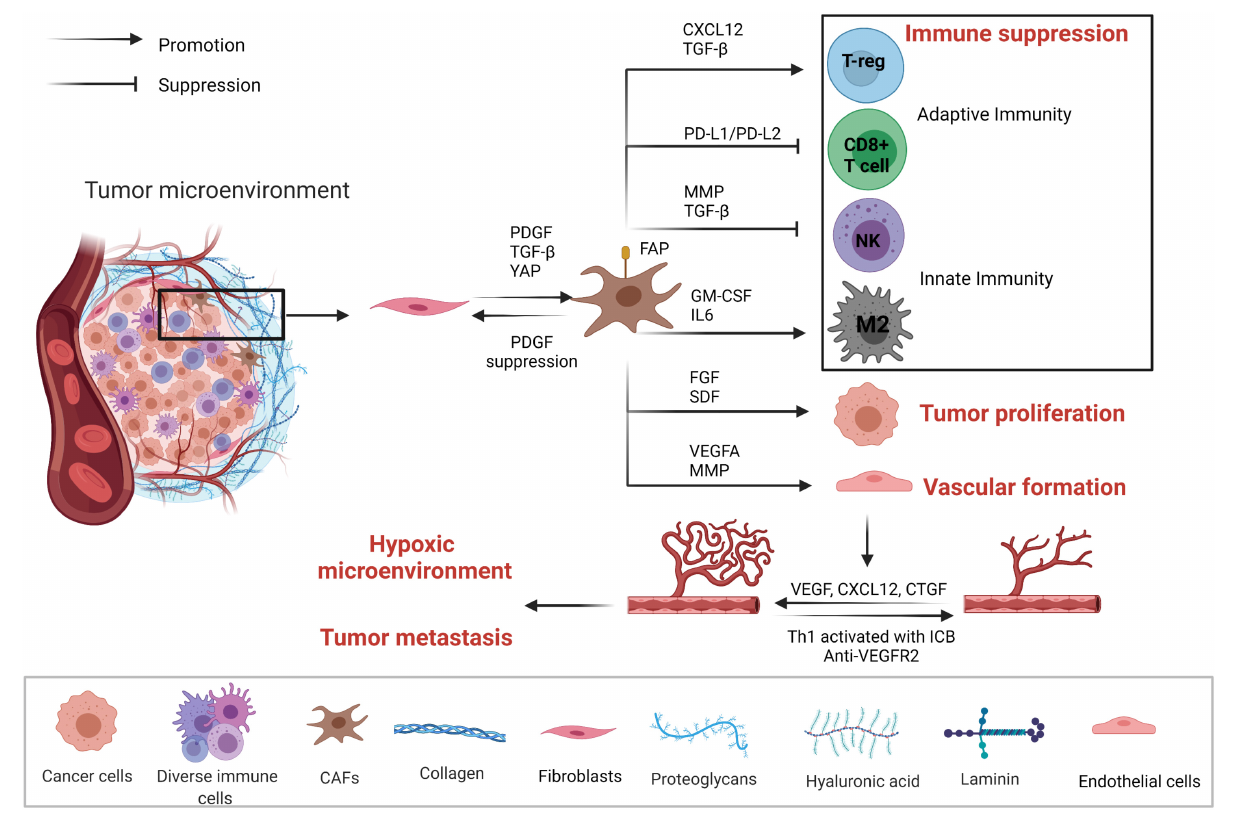
Frontiers in Cell and Developmental Biology |